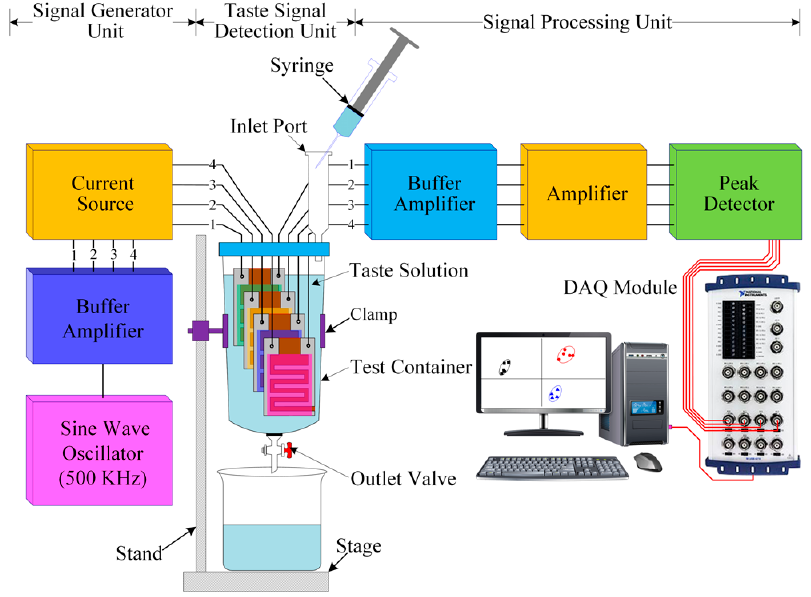
Figure 6. Schematic diagram of the proposed electronic tongue’s experimental setup.